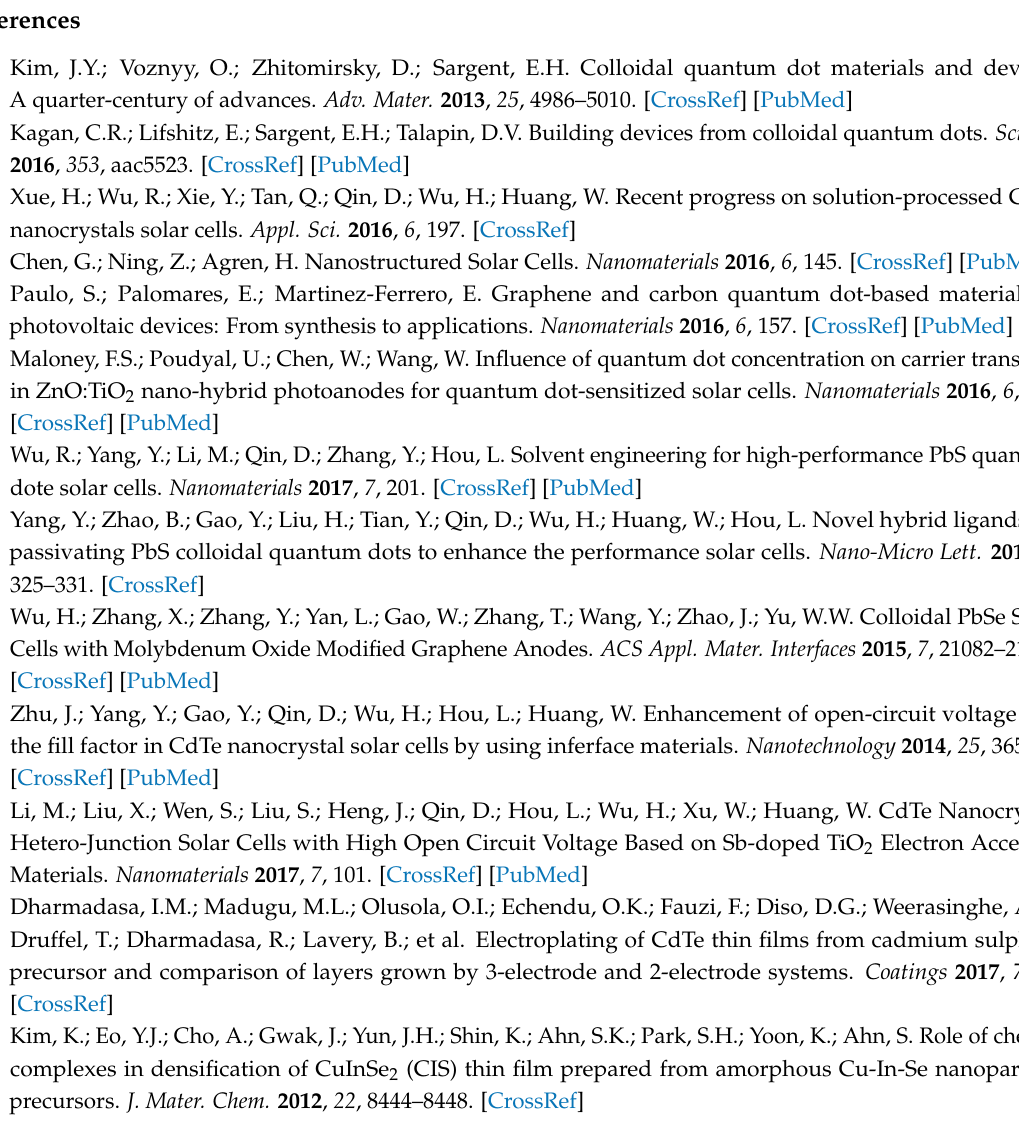
Figure S1: J 1/2 ∝ V curves of CdS NC thin film at different annealing temperatures; Table S1: Conductivity of ITO and ITO/ZnO at different annealing